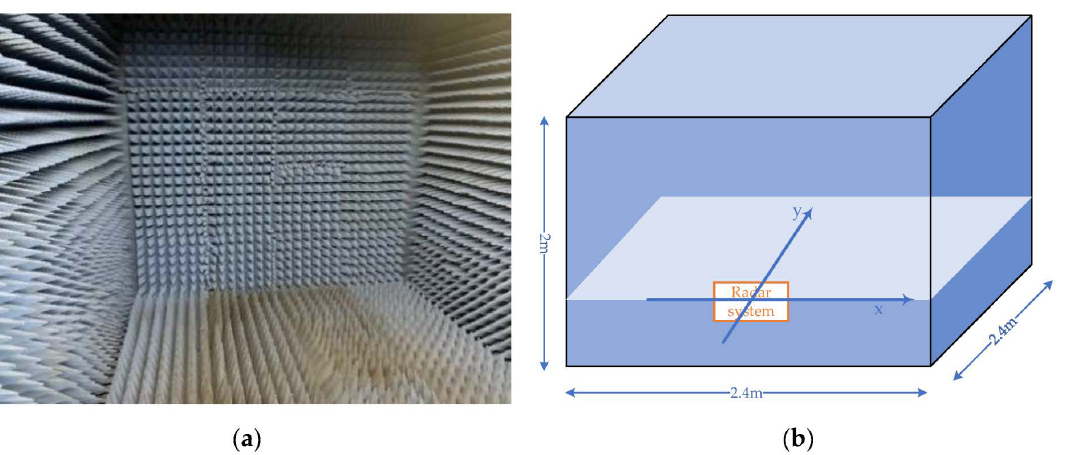
Figure 10. Indoor experimental environment: ( a ) the inside view of the microwave anechoic chamber; ( b ) illustration of the size of the chamber and the coordinate